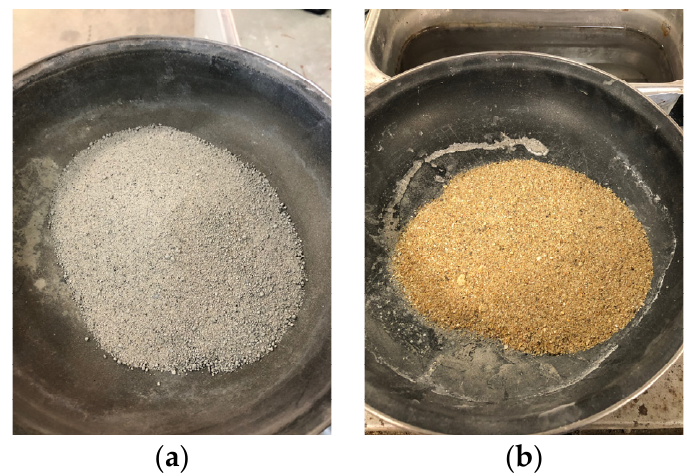
Figure 1. Aggregate grading curve.